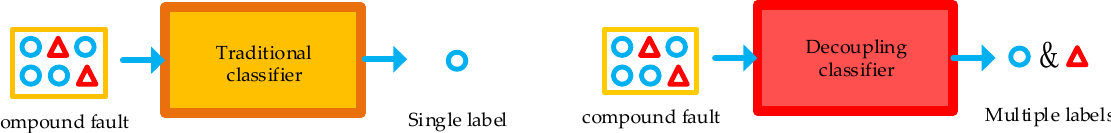
Figure 6. The biggest difference between traditional classifier and decoupling classifier.